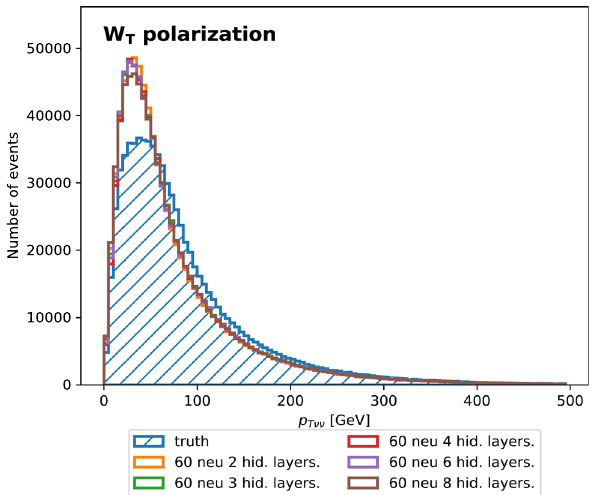
Fig. 16 Reconstruction of p T νν for different neural network topology with the same batch-size, applied on the fully-leptonic channel using a transversely polarized W T scenario